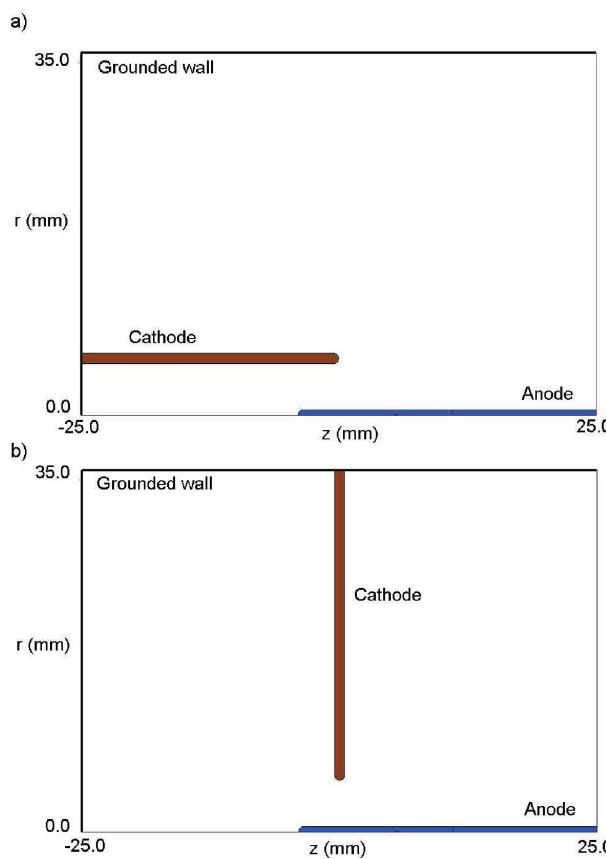
FIG. 1. (Color) Pinched-beam diode geometries for pulsed- beam radiography. The z - r plot shows dimensions in mm for the calculations of this paper. (a) CRAD diode. (b) Rod-pinch